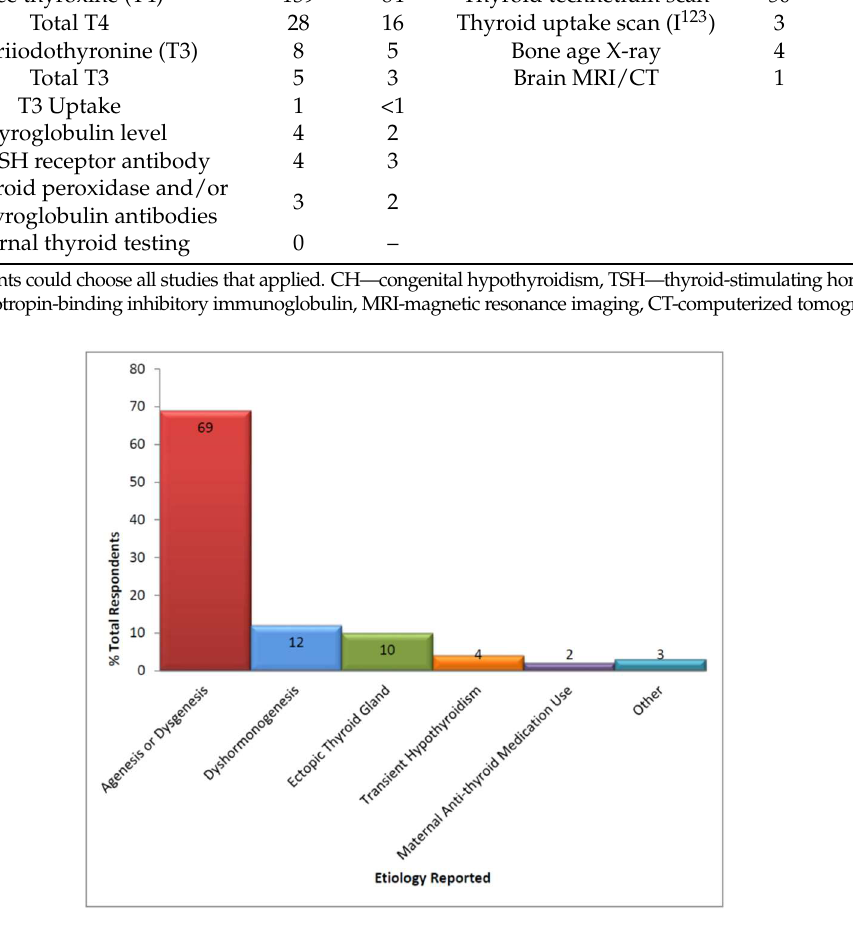
Table 2. Clinicians report of studies used to confirm CH diagnosis *.